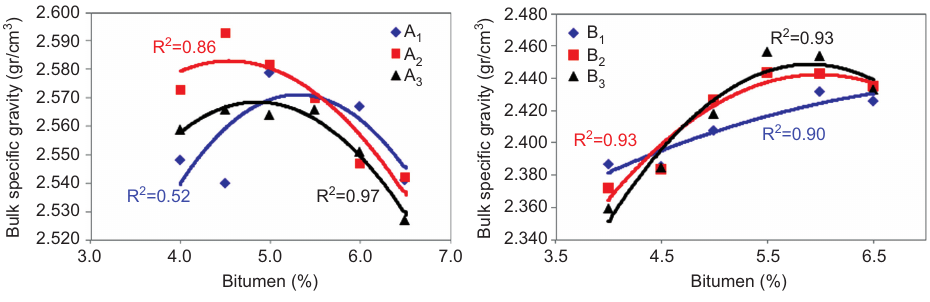
Figure 6 Relation between % bitumen and % bulk specific